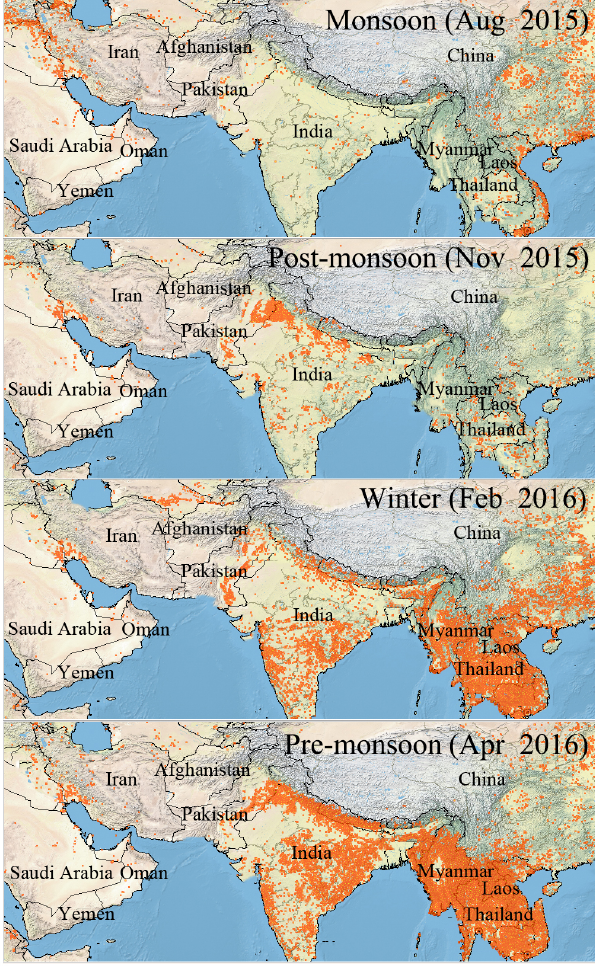
Figure 6. Distribution of fire spots in different seasons from Au- gust 2015 to April